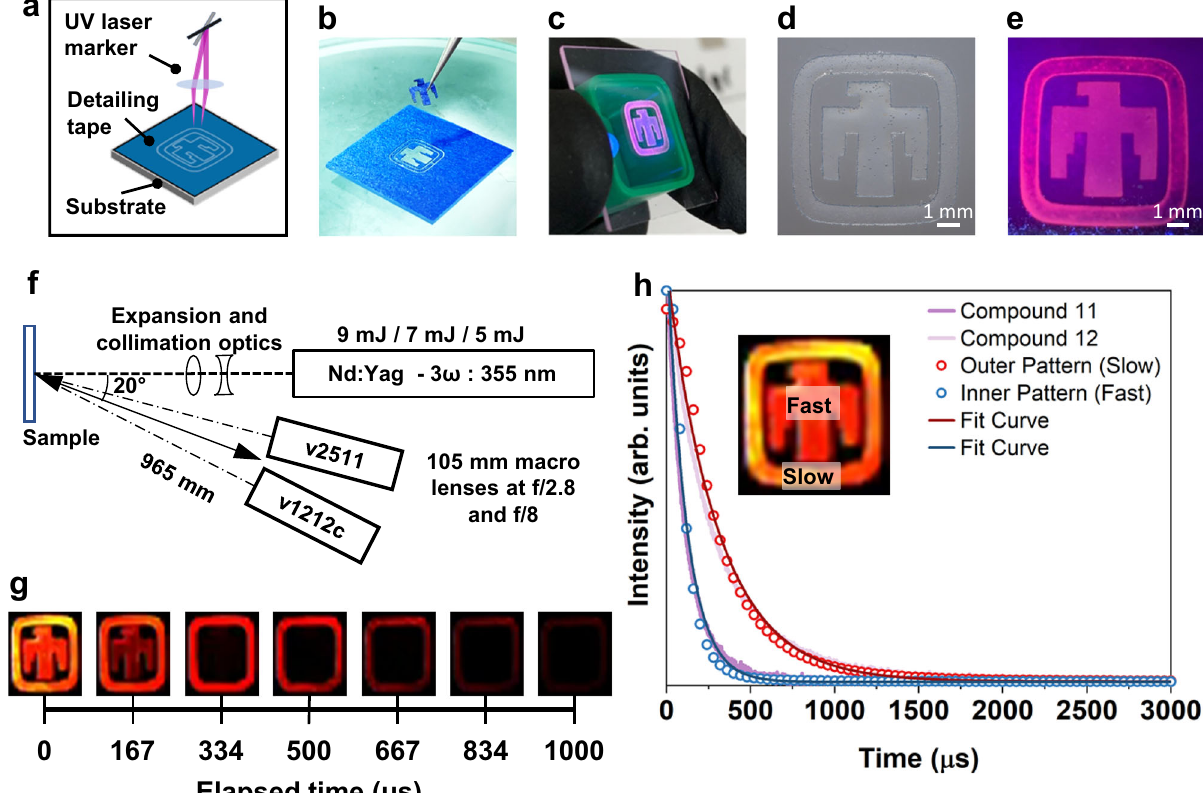
Fig. 7 | A demonstration of patterning and interrogating a tag made with compounds 11 and 12 in an ink. a Diagram detailing stencil design and etching. b Stencil composed of painters ’ tape on glass. c Inked Sandia thunderbird logo under UV light, held in hand for scale. d , e Inked logo under ambient and UV light respectively. f Diagramofthelaserexcitationanddigitalhigh-speedimagingsetup used to capture the decay of the logo. g Time-lapse of tag emission after pulsed